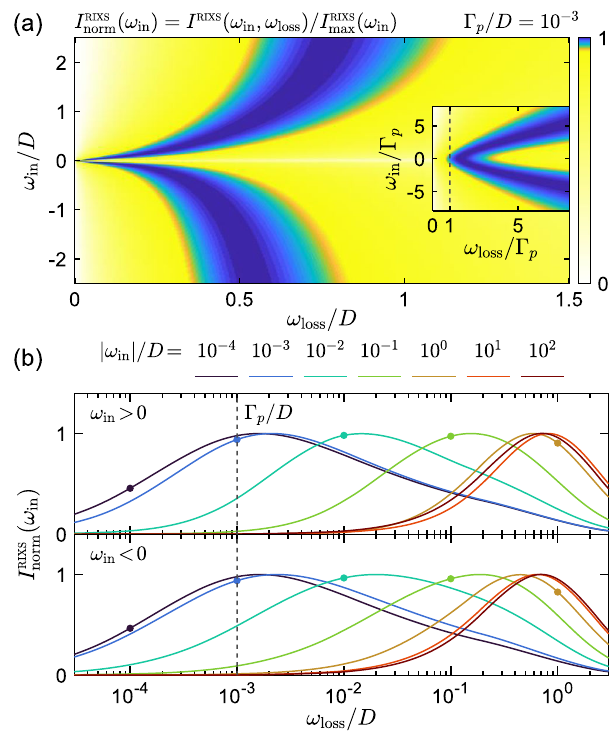
ω ; ω 10. Normalized RIXS spectrum I RIXS of the in loss Þ norm ð MIM (same parameters as for Fig. 8). (a) A color-scale plot using linear frequency axes, and (b) line plots as functions of ω for loss > 0 (upper panel) and ω < 0 (lower selected values of ω in in ω panel), indicated by dots placed at ω . The vertical loss ¼ j in j dashed lines mark the value of Γ . Inset of (a) enlarges the low- p energy region of (a). In (b), the peak positions along the ω axis loss < Γ depend on j ω , occurring at (i) ≃ Γ for j ω ; (ii) ≃ j ω for p p in j in j in j Γ < j ω < D ; (iii) ≃ D for 0 . 5 D ≲ ω p in j in